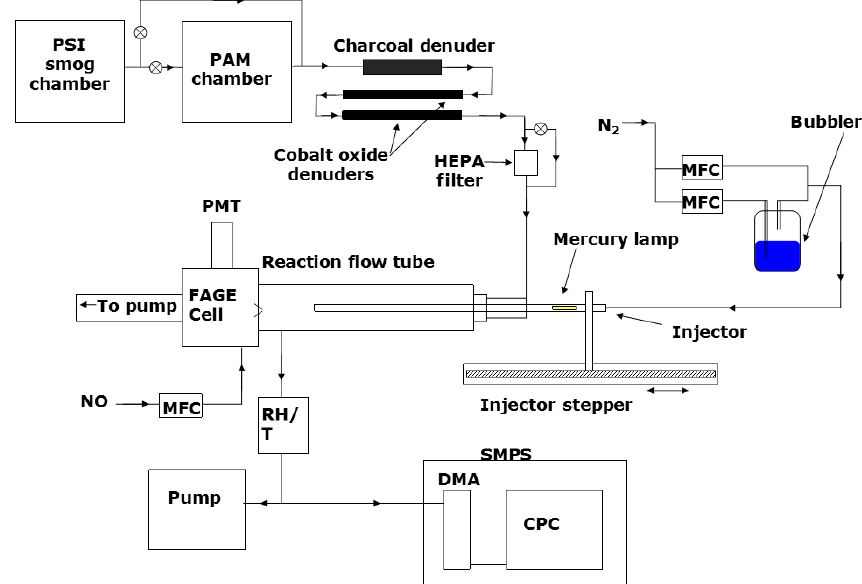
Figure 1. A schematic of the experimental setup used to measure HO 2 uptake coefficients onto SOA aerosol particles. Key: PAM – potential aerosol mass; PMT – photomultiplier tube; FAGE – fluorescence assay by gas expansion; MFC – mass flow controller; RH/ T – relative humidity and temperature probe; SMPS – scanning mobility particle sizer; DMA – differential mobility analyser; CPC – condensation particle counter; HEPA – high-efficiency particulate